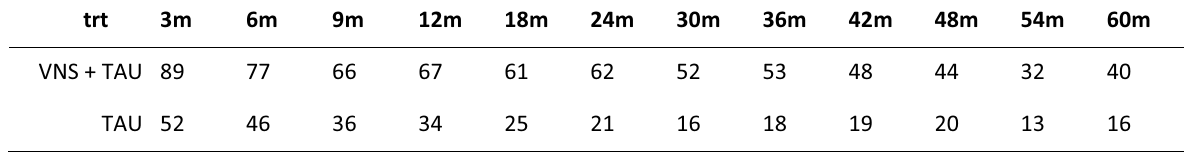
Fig. 2 Mean change in suicidality score from baseline based on MADRS Item